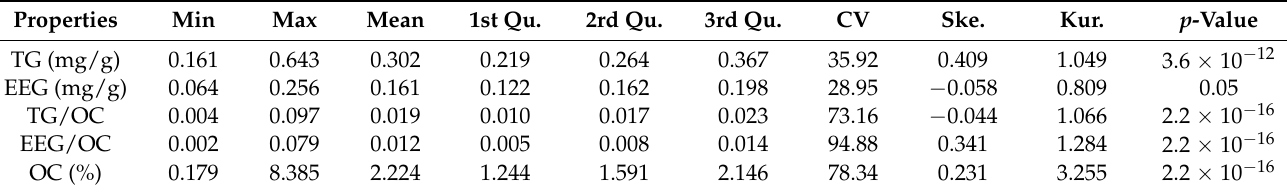
Table 1. Summary of the statistical analysis of used field data (n =